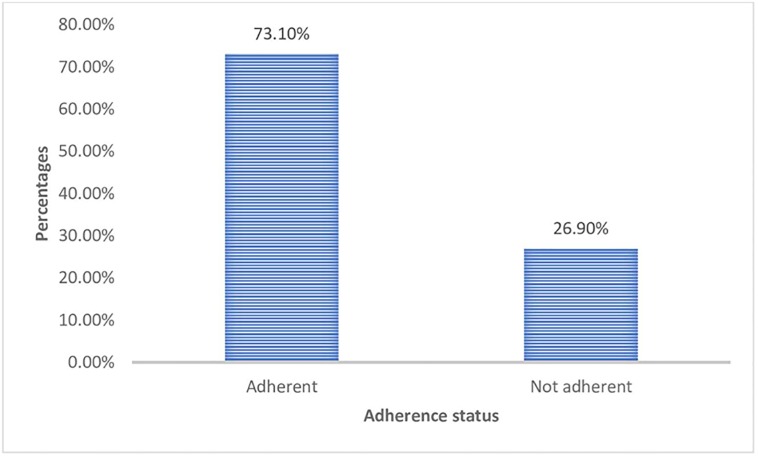
Bar graph showing the level of adherence to antiretroviral medication among HIV/AIDS patients at Nekemte referral hospital, West Ethiopia, 2019.